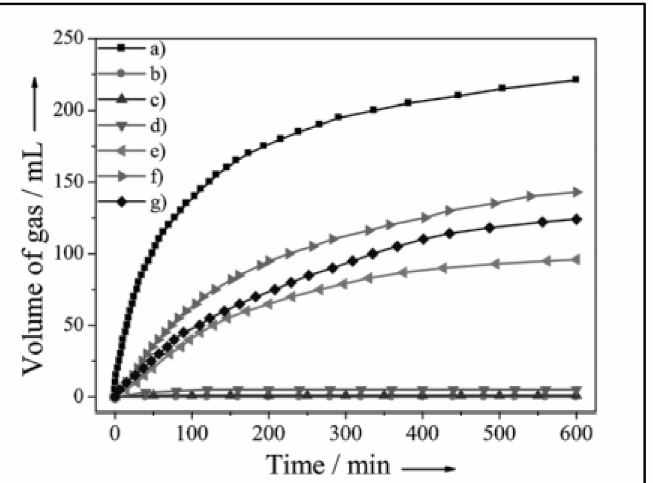
Figure 6. Gas generation by decomposition of FA (0.5 m, 10 mL) versus time in the presence of (a) Co 0.30 Au0.35Pd0.35 /C, (b) Co/C, (c) Au/C, (d) Co 0.30Au0.70 /C, (e) Pd/C, (f) Co 0.30 Pd0.70/C, and (g) Au0.50 Pd0.50 /C (nmetal /nFA = 0.02) at 298 K in ambient atmosphere. Reprinted with permission from ref. [70]. Copyright 2021